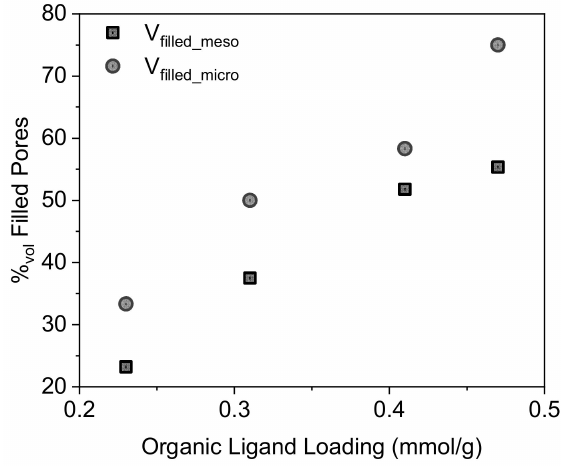
Figure 4. Volume percentage of filled micropores and mesopores after impregnation of the pre- functionalized support as a function of the concentration of organic ligand (DEHCEBP) in the materials.